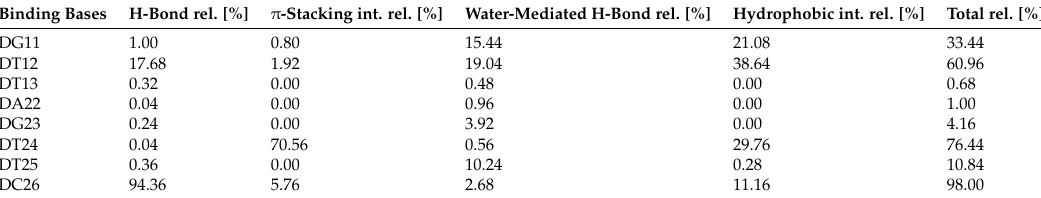
Table 2. Overview of the detected interactions between E2 and the bases of E2-specific aptamer during the 25 ns MD simulation. The relative (rel.) frequency of the detected interactions H-bonds, π -stacking interactions, water-mediated H-bonds, and hydrophobic interactions are displayed. The last column shows the relative frequency of the respective base, which forms an interaction with E2 during the whole 25 ns simulation time. H-bonds, hydrogen